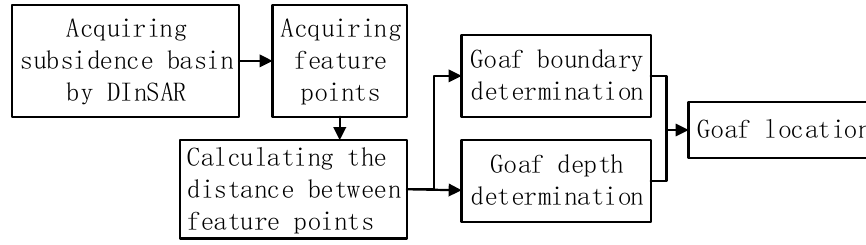
Figure 4. Flowchart of goaf